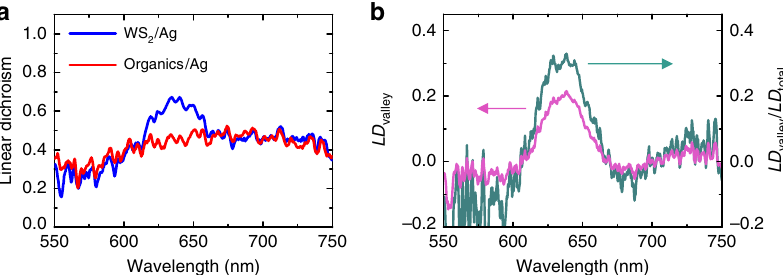
Fig. 6 Resolving the polarization induced by the valley coherence from the total polarization. a Comparison of the linear dichroism between two kinds of hybrid nanostructures. The linear dichroism of the WS 2 -Ag hybrid is always higher than that of the organics-Ag hybrid at the emission wavelength of the valley excitons (~636nm). The organics is primarily the fl uorescent moieties of PMMA residue. b The linear dichroism induced by the valley coherence (pink curve) and its percentage in the total polarization (green curve). Note that LD